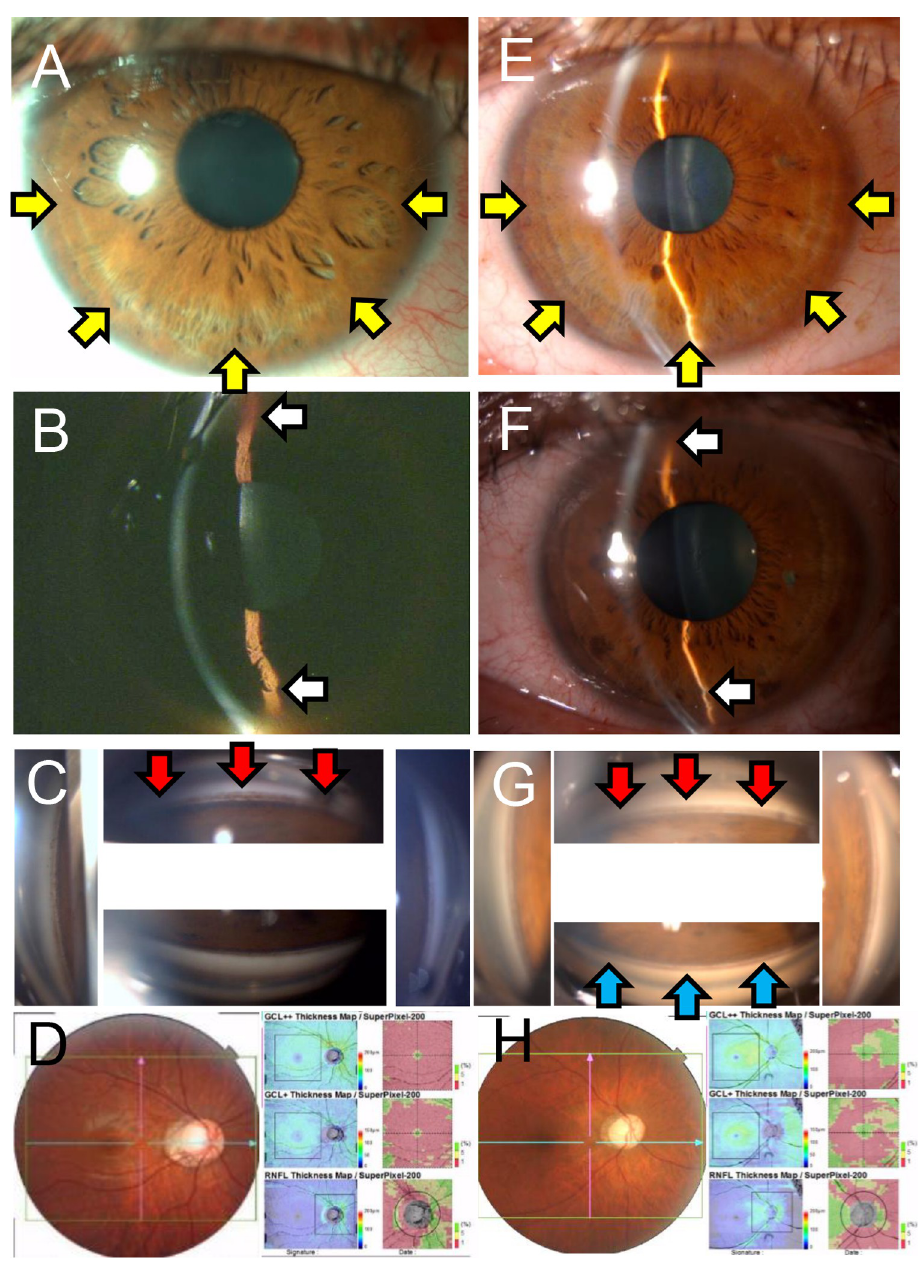
Fig 1. Representative cases of pigmentary glaucoma in Japanese subjects. Slit-lamp and gonioscopic images, and fundus photographs of the right eyes of a 28-year-old man with pigmentary glaucoma (PG) (Case 4, A, B, C, D) and a 45-year-old man (Case 9, E, F, G, H) with PG. Both were Japanese. Midperipheral iris depigmentation (yellow arrows) and iris concavity (white arrows) can be seen in the slit-lamp images. Dense pigmentation of the trabecular meshwork and Schwalbe line (red arrows) can be seen in the gonioscopic images. The pigment reversal sign (upper > lower pigmentation; blue arrows) can be seen in the 45-year-old case.